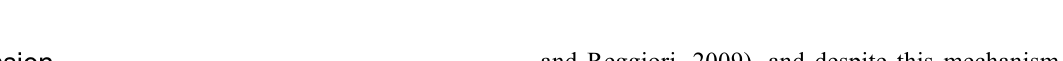
Figure 4 - Heatmap showing the clustered cellular components based on the Gene Ontology (GO) analysis of autophagy, lipid metabolism, and proteostasis (ALP) network-associated communities/clusters. Heatmap rows and columns were grouped using the k- means distance-based method. Horizontal and vertical dotted lines indicate the cut-off point used to define the numbered rows and column